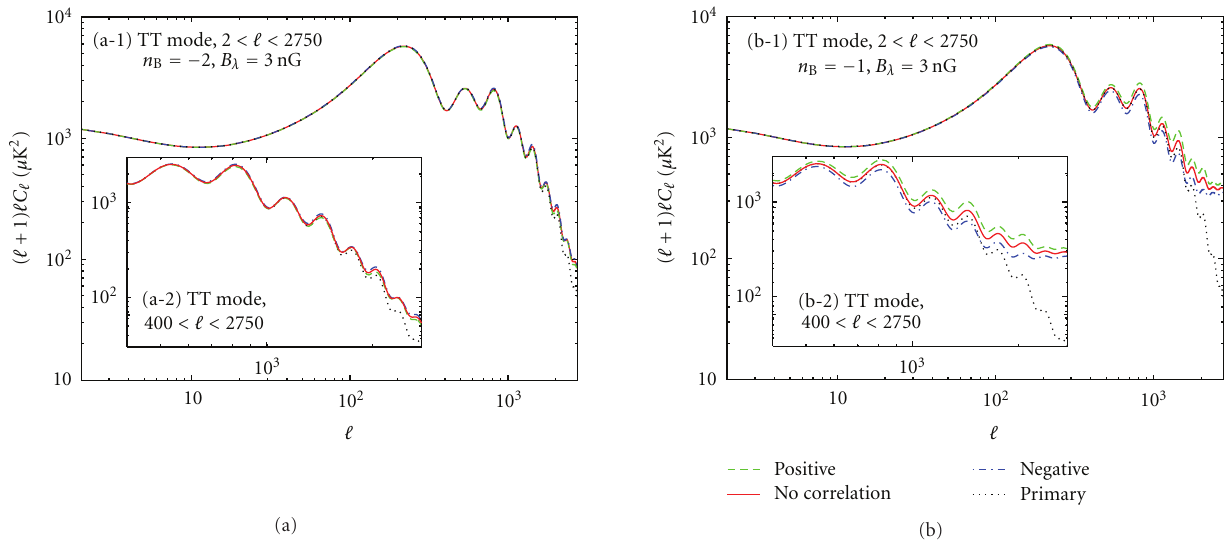
Figure 5: CMB temperature fluctuations from the PMF. Plots show various ranges for (a-1) and (b-1) TT (2 < (cid:11) < 2750) and (a-2) and (b-2) TT (400 < (cid:11) < 2750) with B λ = 3 . 0 nG and n B = − 2 . 0 (a) or − 1.0 (b). Green-dashed, red-bold, blue-dashed-dotted, and black-dotted curves show positive, no, and negative correlations, respectively. The black-dotted curve shows the primary spectrum without a PMF.